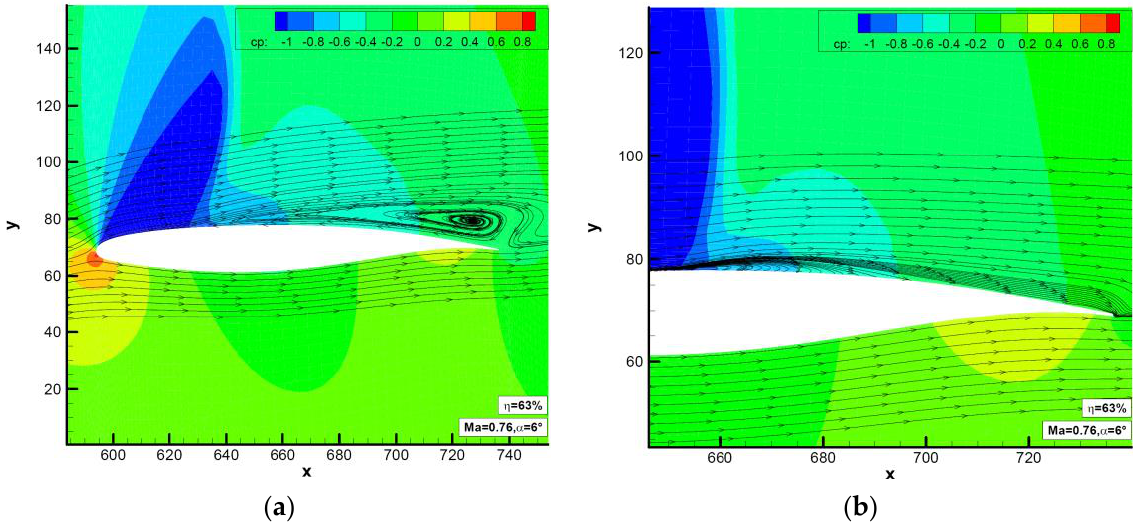
Figure 21. Numerical flow structures at different Reynolds numbers (M = 0.76, η = 63%, α = 6°): ( a ) Re = 3.3 × 10 6 ; ( b ) Re = 35 × 10 6 .